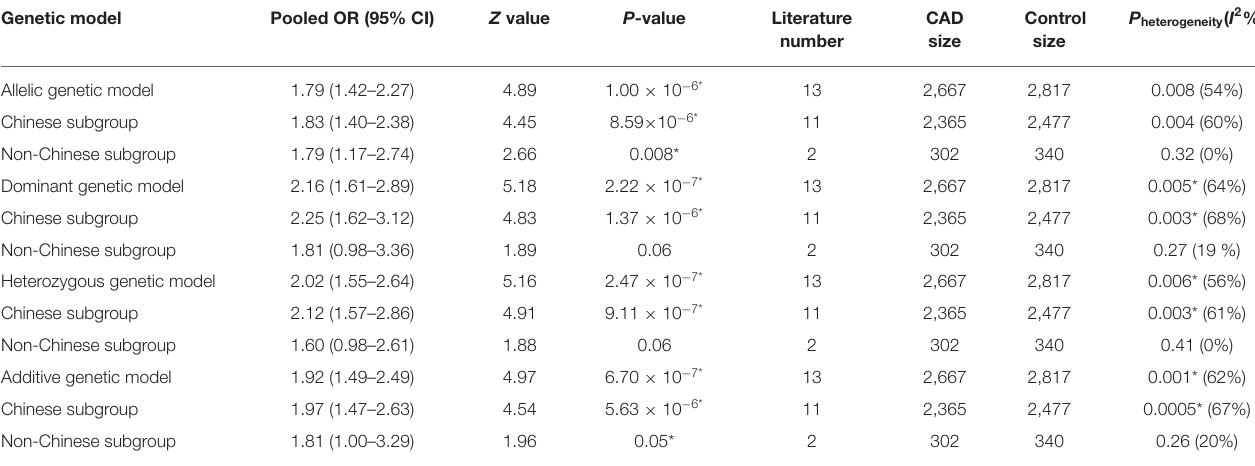
TABLE 2 | Summary of meta-analysis of association between PCSK9 gene E670G (rs505151) polymorphism and CAD. Genetic model Pooled OR (95% CI) Z value P -value